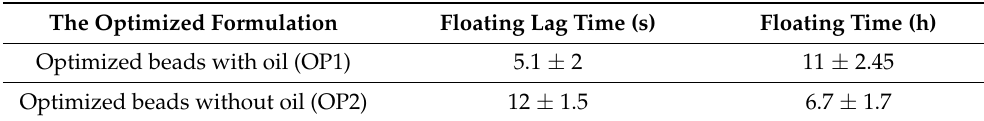
Table 7. In vitro floating of optimized formulation (OP1 and OP2).